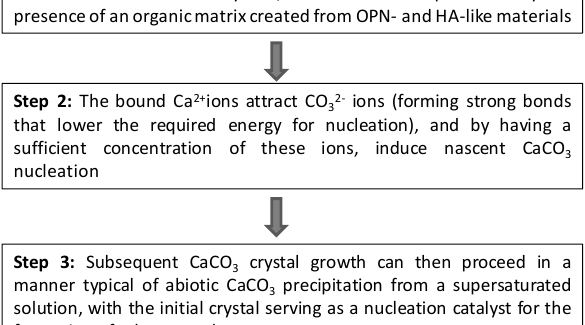
Fig. 7. Proposed epitaxial growth sequence for CaCO 3 crystal fi-